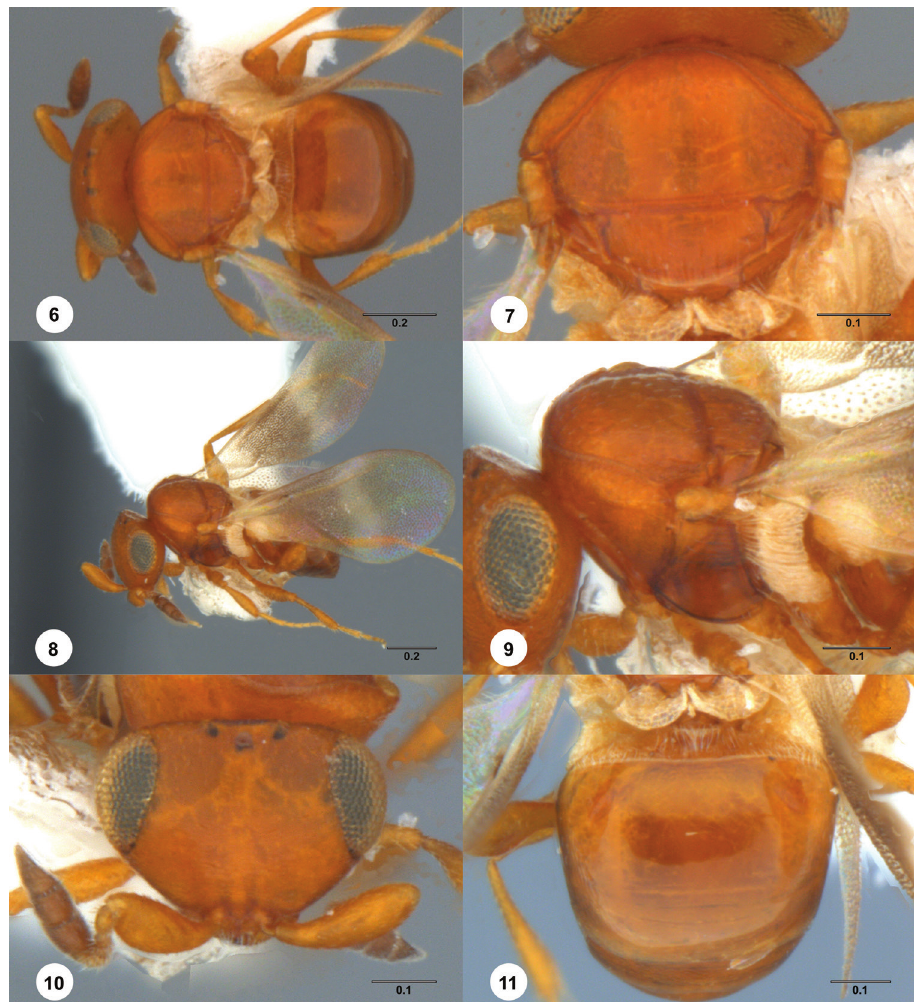
Figures 6–11. Pulchrisolia ankremos , female holotype (OSUC 666426) 6 head, mesosoma, metasoma, dorsal view 7 mesosoma, dorsal view 8 head, mesosoma, metasoma, lateral view 9 mesosoma, lateral view 10 head, anterior view 11 metasoma, dorsal view. Scale bars in millimeters. than radicle. Coloration of clavomeres: darker than funicle. Hyperoccipital carina: sunken between lateral ocelli. Frontal ledge: present. Preocellar depressions: absent. Setation of pronotal cervical sulcus: absent. Setation of cervical pronotal area: present. Sculpture of pronotal shoulders: reticulate. Sculpture of anterior margin of pronotal shoulders: carinate. Posterolateral margin of pronotal shoulders: sharply angled. Pos- terior margin of pronotal shoulders: rounded. Antero-admedian line: absent. Anterior admedian depression or pit: present. Parapsidial line: absent. Median mesoscutal line: absent. Notaulus: absent. Color of mesoscutum: concolorous with pronotum. Shape of mesoscutum in lateral view: flat to slightly convex. Scupture of mesoscutum: